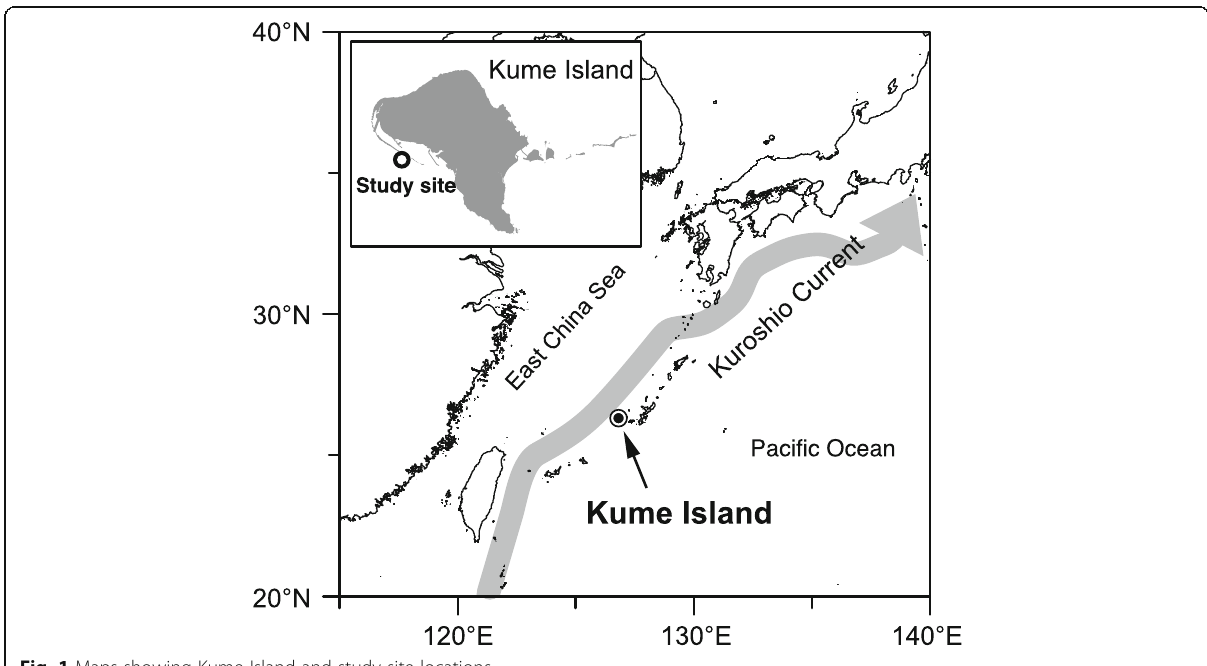
Fig. 1 Maps showing Kume Island and study site